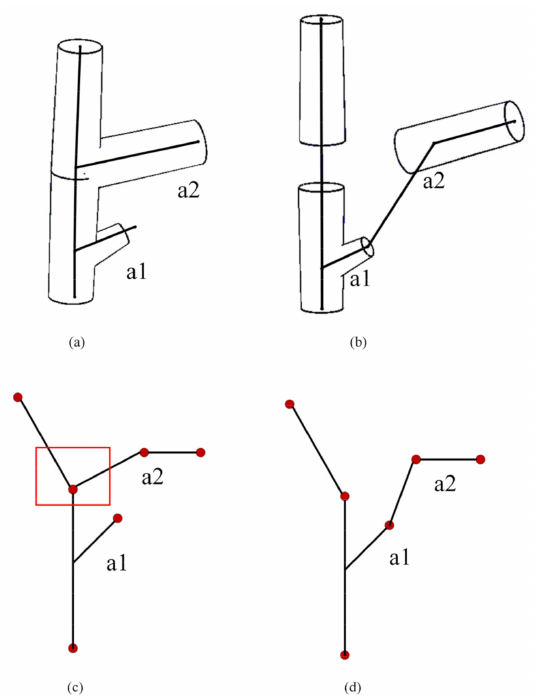
Figure 1. Schematic diagram of topological connection of bifurcation structure of the branch. ( a ) True trunk skeleton; ( b ) Structural fracture of branches; ( c ) True trunk skeleton line; ( d ) Missing branches causes skeleton errors. In the figure, black lines are skeleton lines, a1 and a2 are branches, red dots in ( c , d ) are skeleton points, and the red frame is the region where parts of the point cloud are